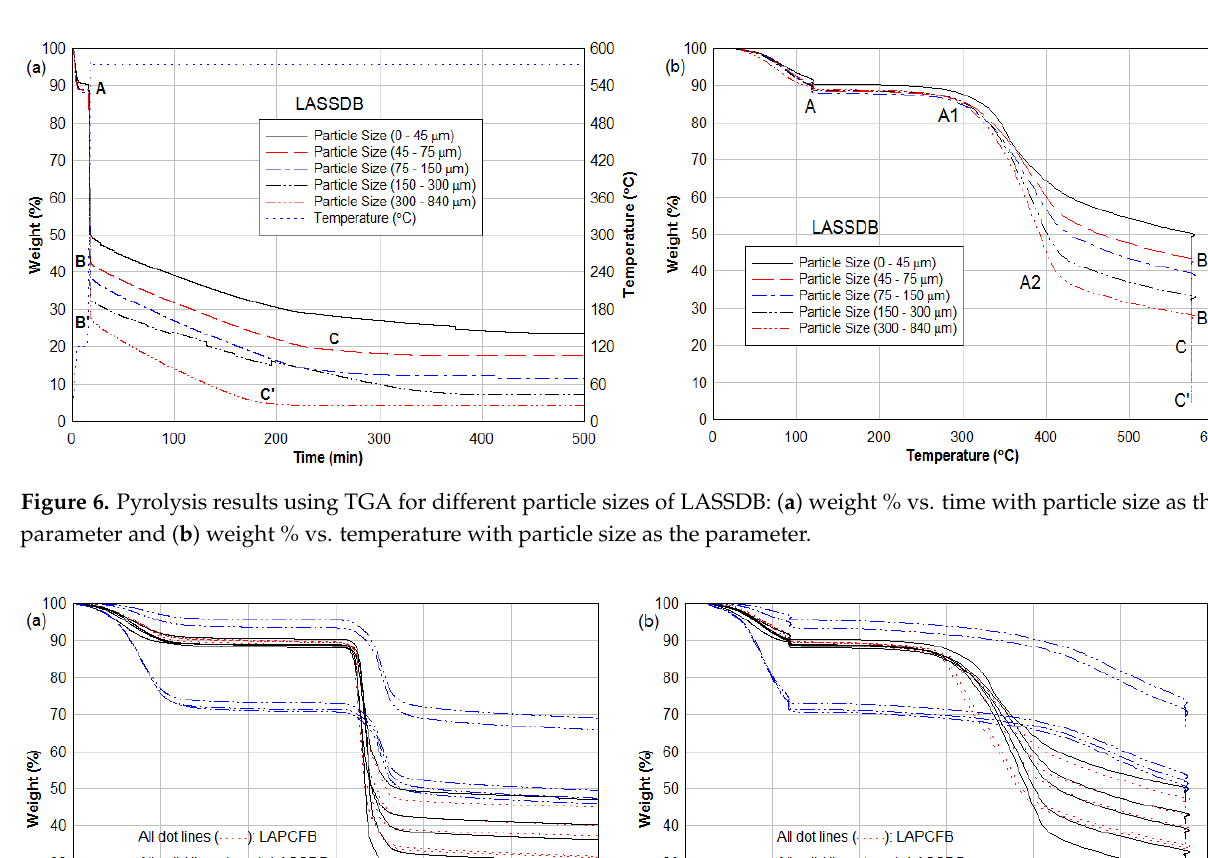
Figure 7. Moisture and volatile released during pyrolysis using TGA for different particle sizes of all fuels: ( a ) Particle size vs. time and ( b ) Particle size vs. temperature.